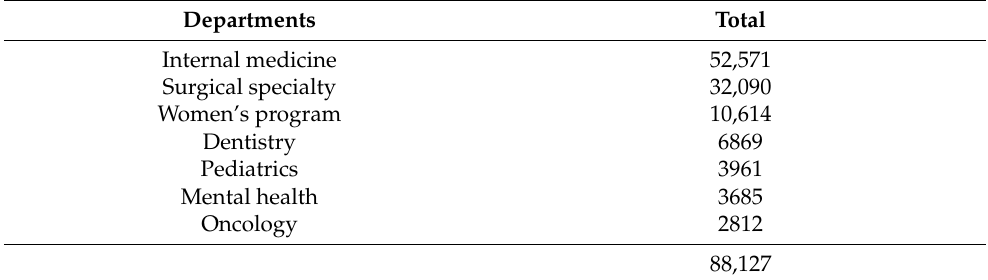
Table 1. Patients under medical management (differentiated by clinical departments, up to June 2021).